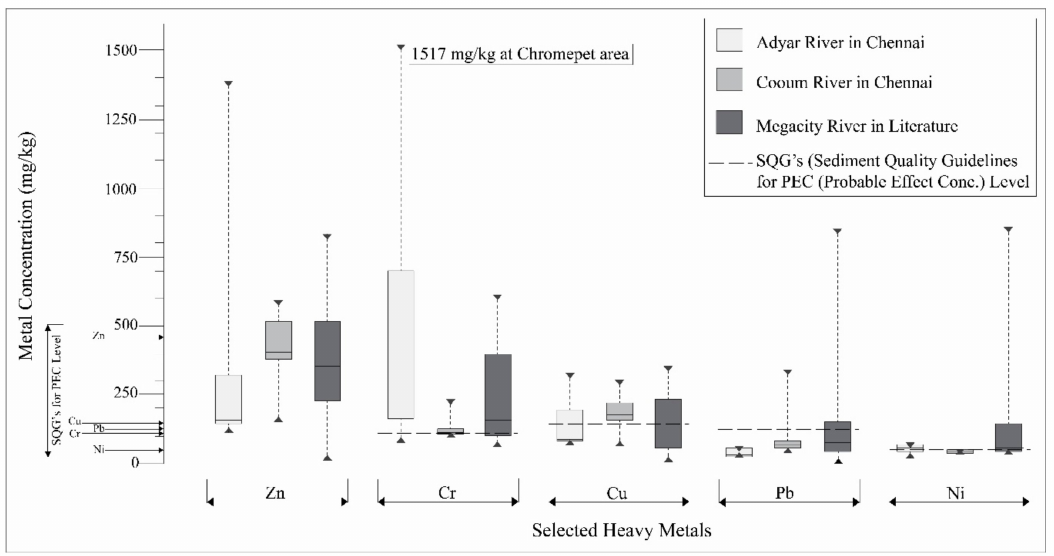
Figure 5. Box plots of selected ubiquitous trace elements comparing Chennai sediment quality to that of worldwide megacity sediments using